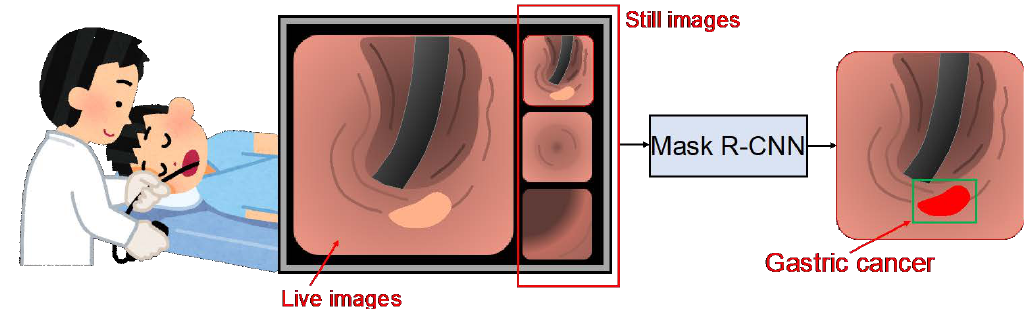
Figure 1. Schematic of the study outline.